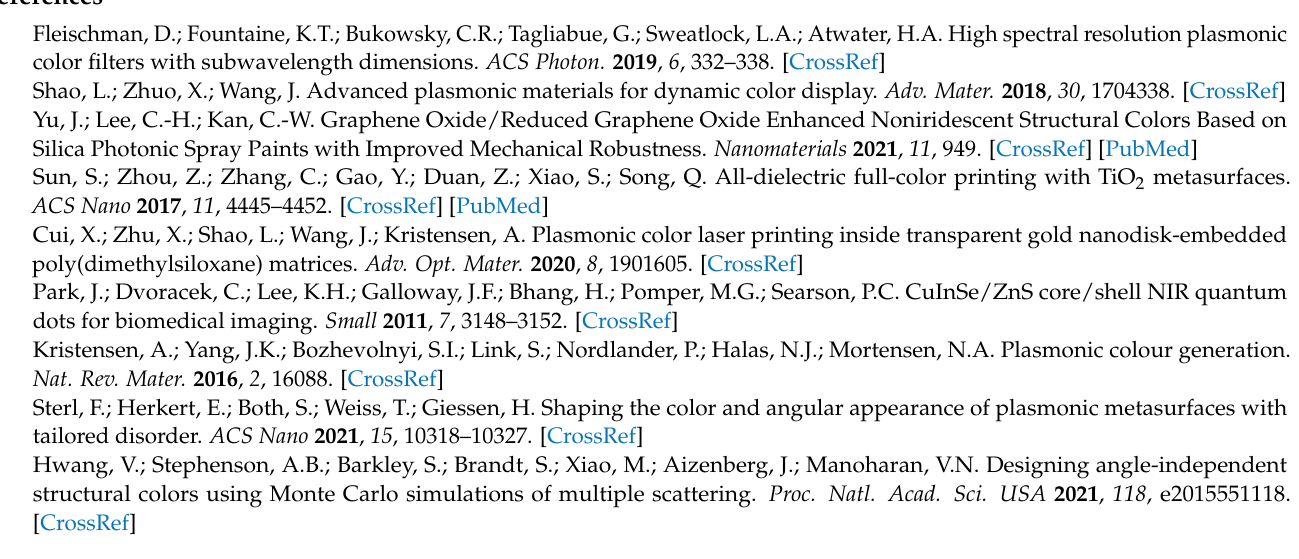
Table S1. Color properties of gold nanoparticle systems composed of different geometric